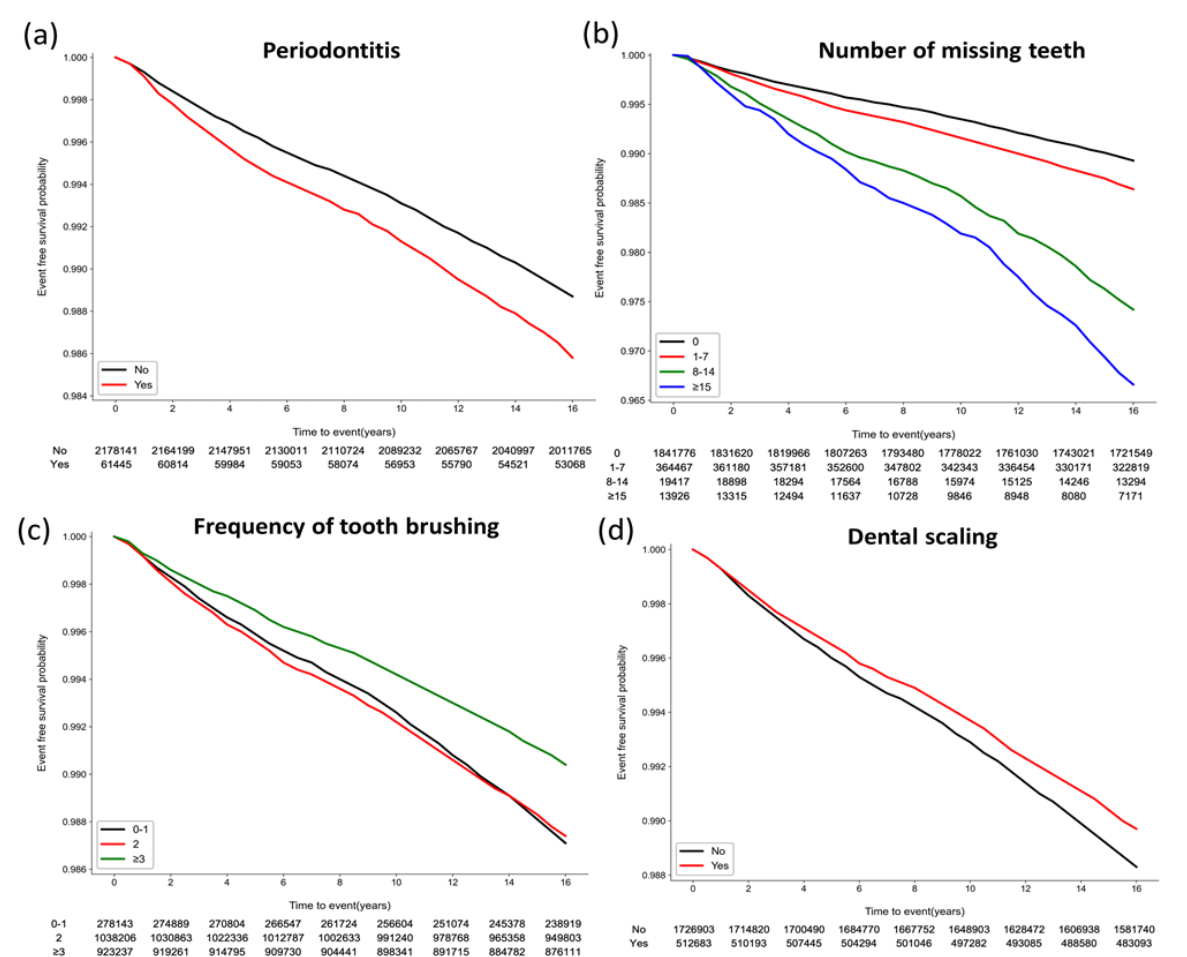
Figure 2. Kaplan–Meier survival curve associated with oral health status and oral hygiene behaviors for occurrence of rheumatoid arthritis. ( a ) Periodontitis ( p < 0.001). ( b ) Number of missing teeth ( p < 0.001). ( c ) Frequency of tooth brushing (times/per day) ( p < 0.001). ( d ) Dental scaling within the previous year ( p < 0.001).